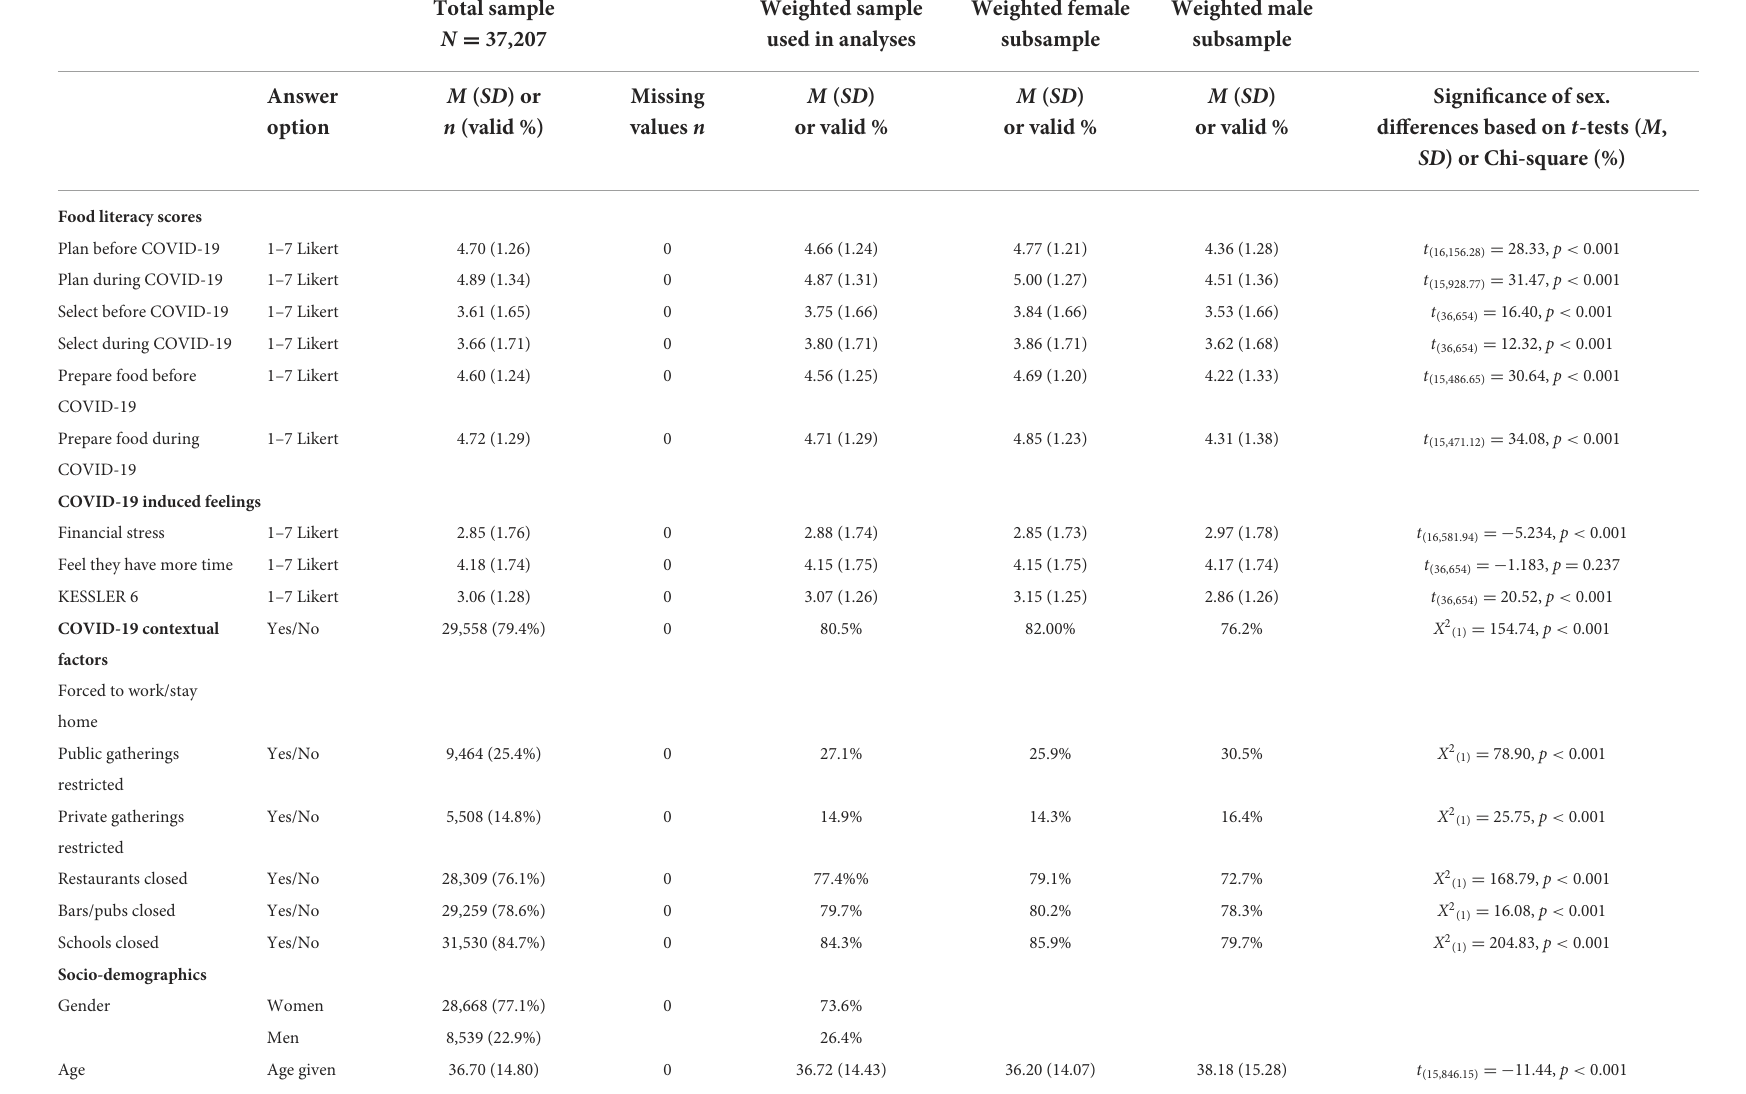
TABLE 1 Detailed descriptive statistics (Means, Standard Deviations, and Valid Percentages) for the entire sample, weighted a and subsamples of women and men, used in all analyses. Total sample Weighted sample N = 37,207 used in